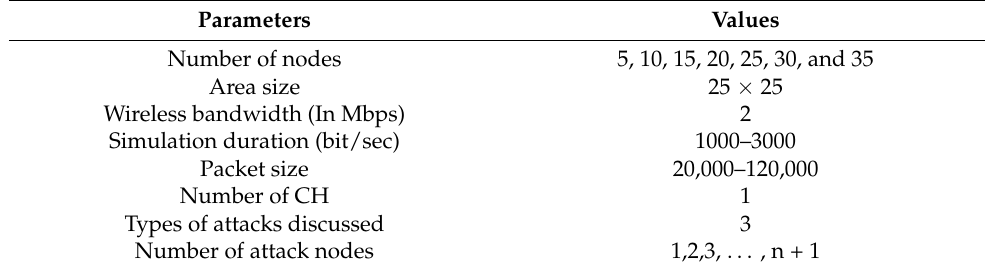
Table 2. Parameters and their Respective